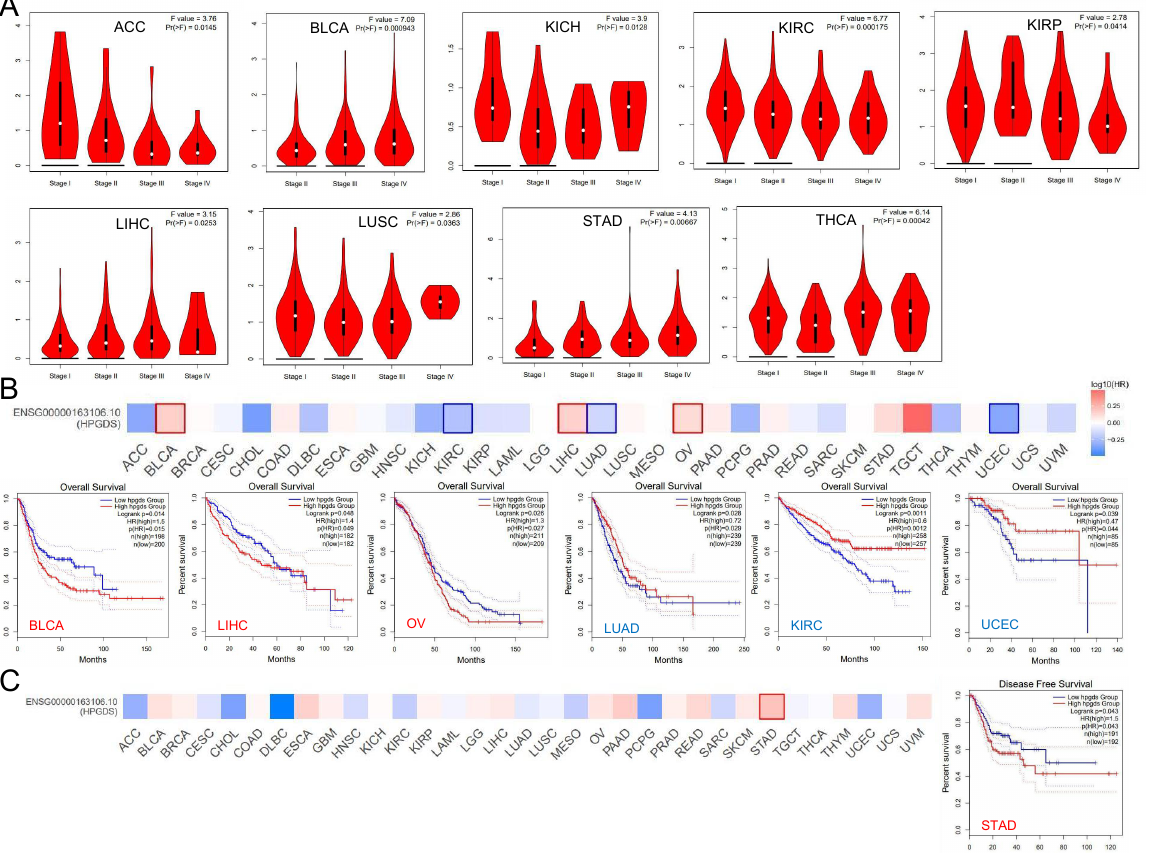
Figure 2. Schematic diagram for analysis the content of free and combined phytosterols in rapeseed Figure 2. Analysis of the TCGA database to investigate correlations between expression of HPGDS and its products (rapeseed oil and cake) during rapeseed microwave pretreatment and the oil and cancer prognosis. ( A ) The expression level of HPGDS was analyzed according to the main production process. pathological stages (stage I, stage II, stage III, and stage IV) of different cancers. The equation Log2(TPM + 1) was applied to calculate the log scale. ( B , C ) The OS and DFS of different cancers according to the TCGA database were analyzed relative to expression of